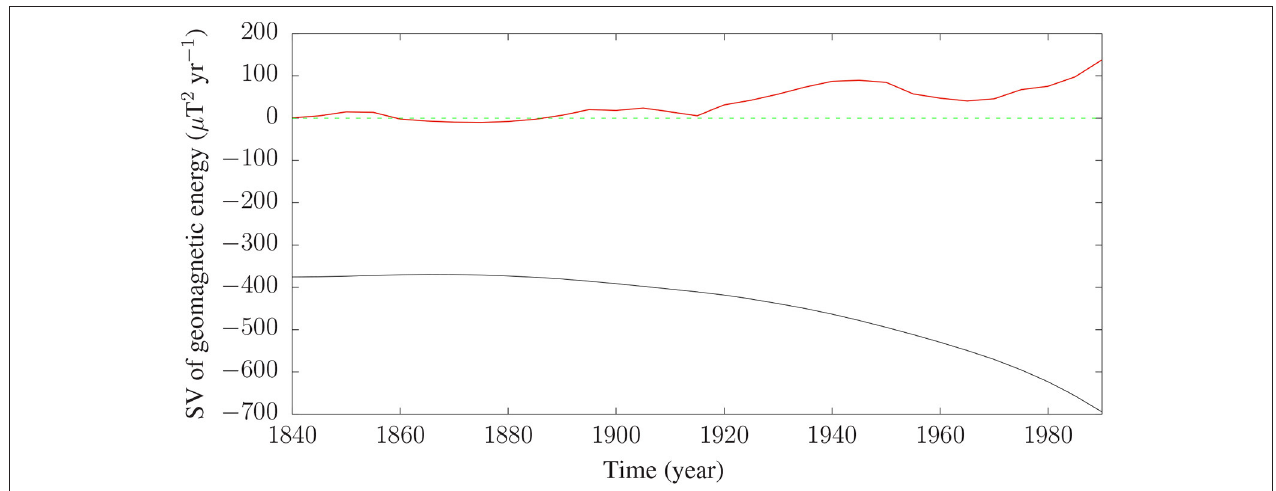
FIGURE 9 | The SV of the total geomagnetic energy on the CMB ˙ E b as a function of time for gufm1 in the period 1840–1990 (red; Jackson et al., 2000) and its diffusive contribution with λ ∗ = 100 m 2 s − 1 (black). The red line is the same as in Figure 2 .